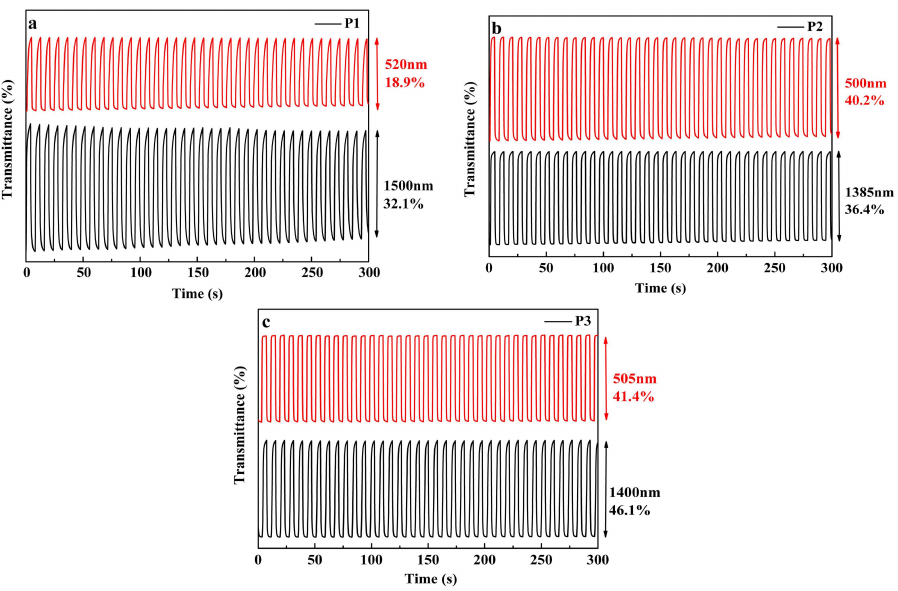
Figure 6. Electrochromic switching of P1 ( a ); P2 ( b ); and P3 ( c ) at different